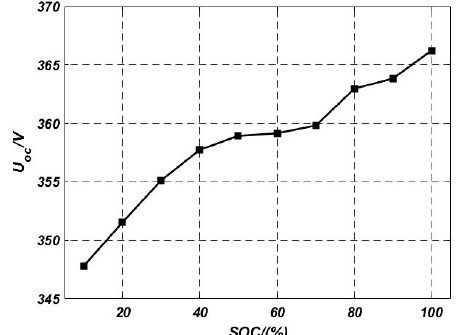
Figure 6. Battery OCV as a function of battery